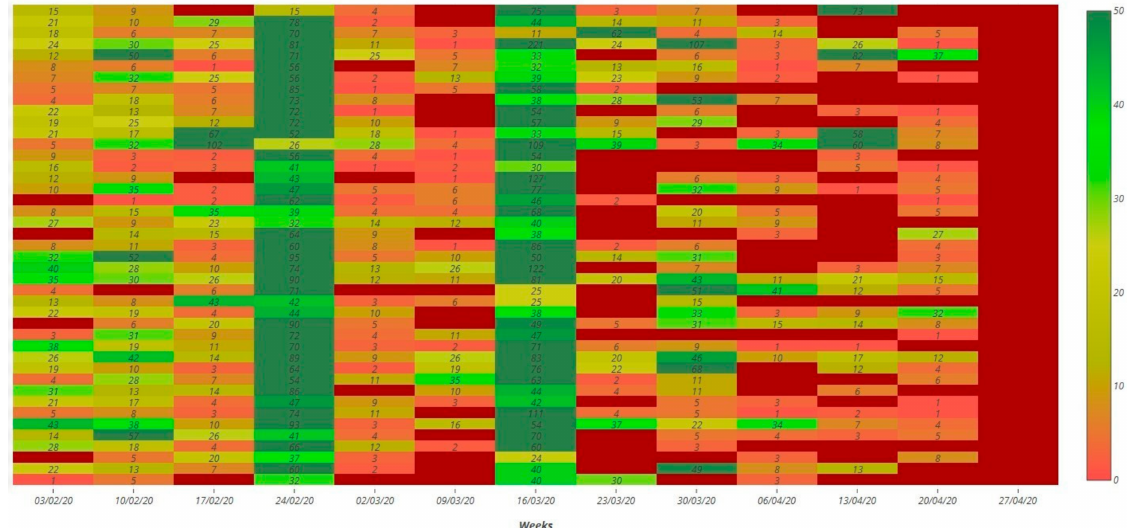
Figure 4. Heat map of the weekly monitoring of students and detection of outliers in Moodle carried out with UBUMonitor